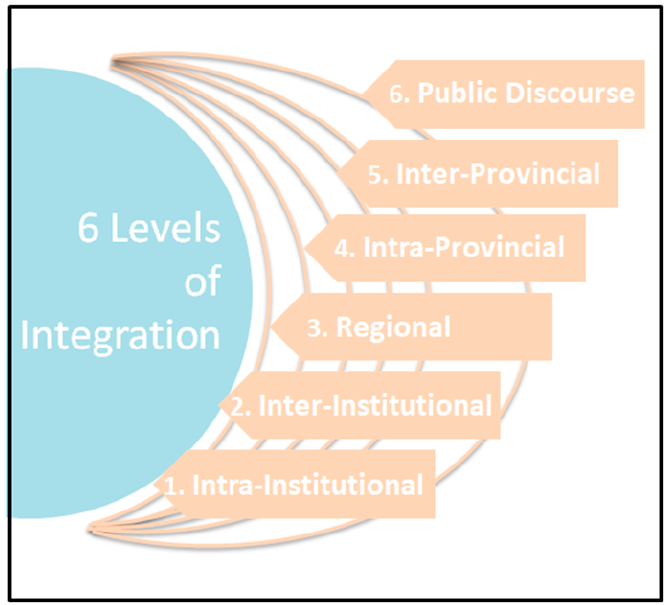
Figure 1. 6 Levels of Integration in Palliative Care.